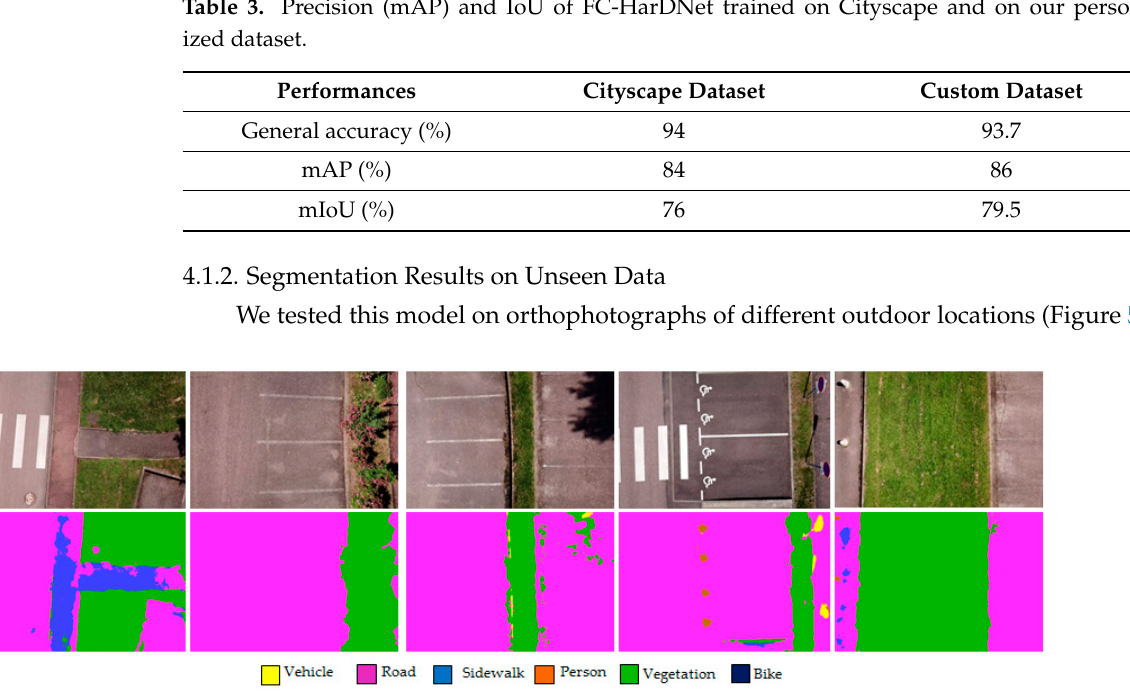
Figure 5. Segmentation of unseen orthophotographs, obtained with a drone at an altitude of 10